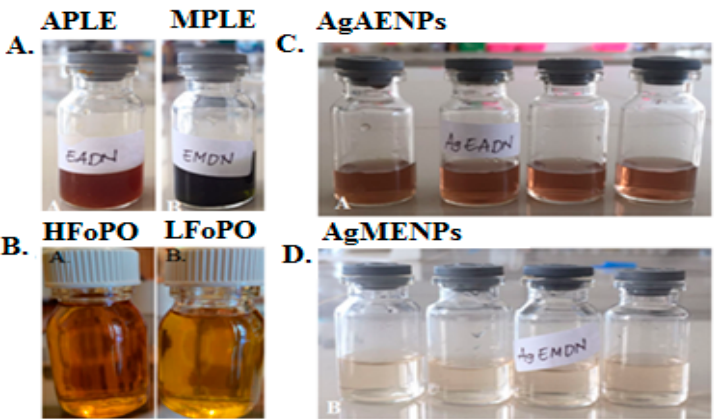
Table 1. Phytochemicals Aqueous patchouli leaf extract (APLE) and methanolic patchouli leaf extract (MPLE) Screening.